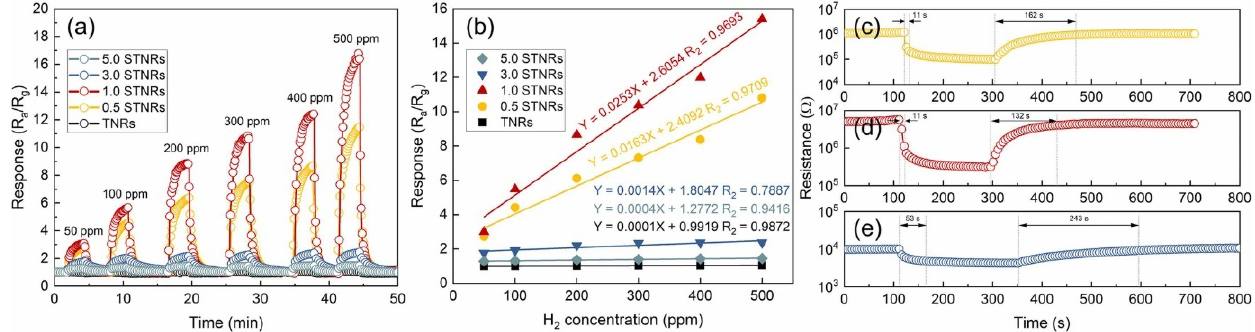
Figure 30. ( a ) Response–recovery curves of the sensors based on TNRs and STNRs toward H 2 with various concentrations at 100 °C. ( b ) Relationships between the response and H 2 concentration for the TNRs and STNRs. ( c – e ) Response/recovery times of the 0.5 STNRs, 1.0 STNRs, and 3.0 STNRs toward 500 ppm H 2 , respectively. Reprinted from [115].